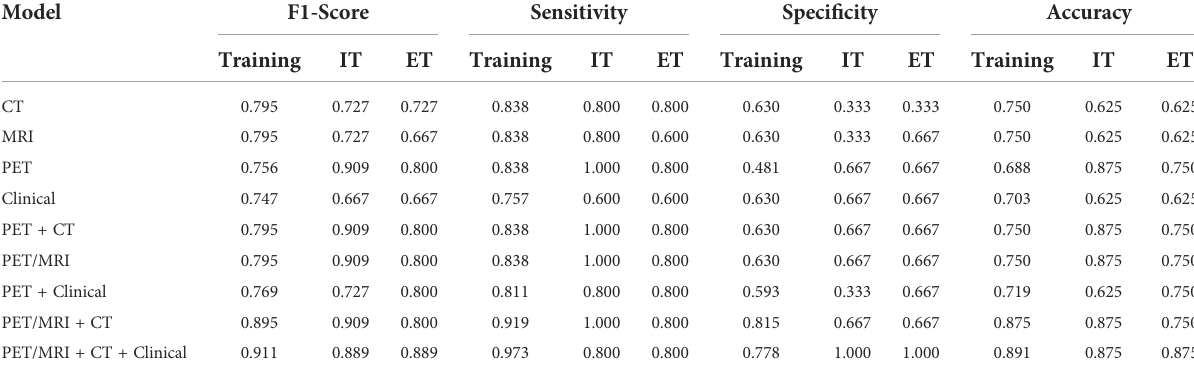
TABLE 3 F1-score, sensitivity, speci fi city, and accuracy of different prediction models (IT represented internal testing, and ET represented external testing). Model